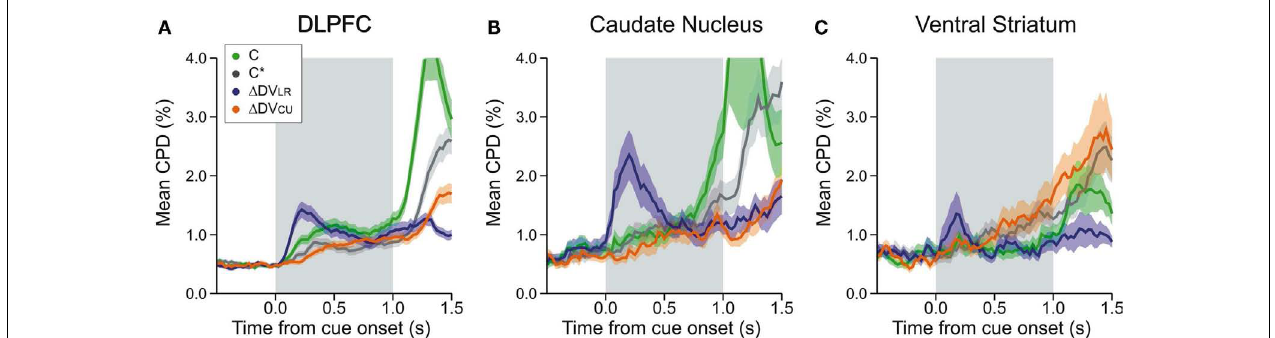
the animal’s choice between the left and right target ( C , green), its choice between red and green target ( C *, gray), the difference in the DVs for the left and right targets ( ∆ DV LR , blue), and the difference in the DVs for chosen and unchosen targets ( ∆ DV CU , orange). Shaded areas, SEM.